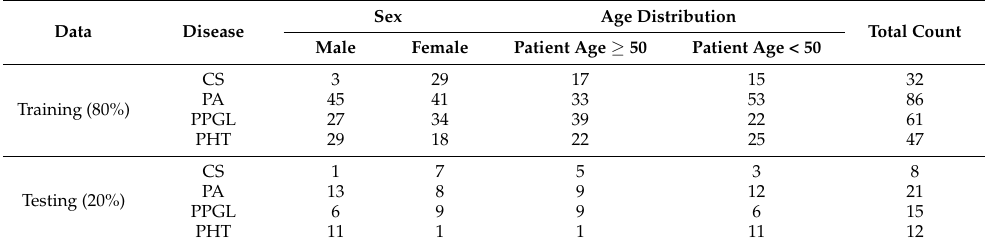
Table A2. Details of randomly partitioned training and testing datasets.